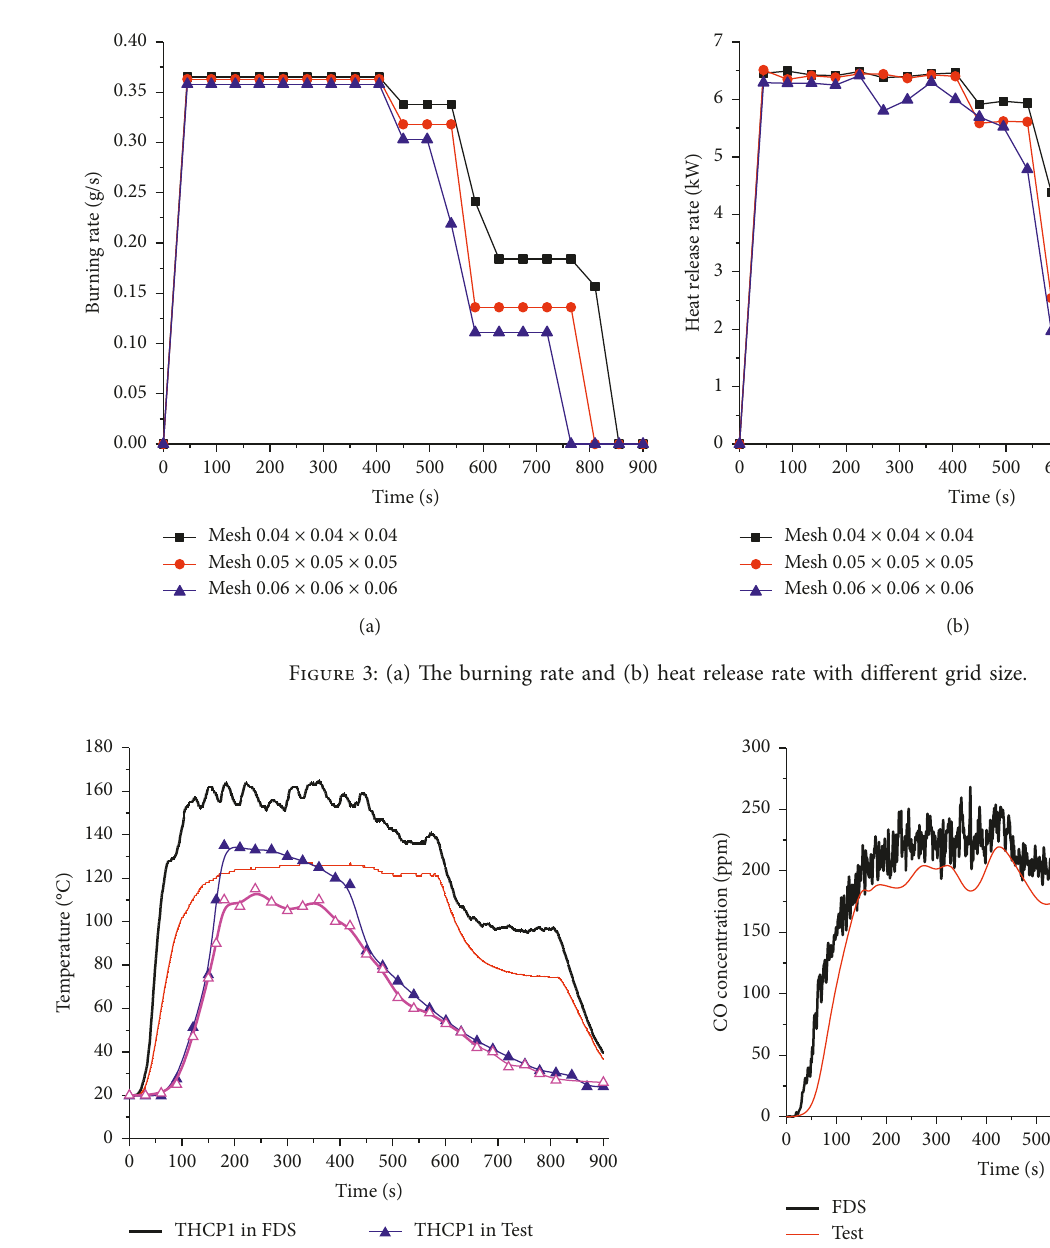
Figure 5: CO concentration in test and